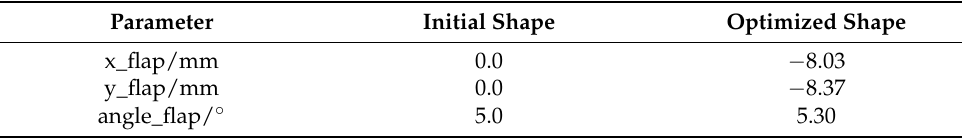
Figure 19. Variation of far-field lift-drag (L/D) and OASPL. Table 7. Comparison of initial shape and optimized shape.